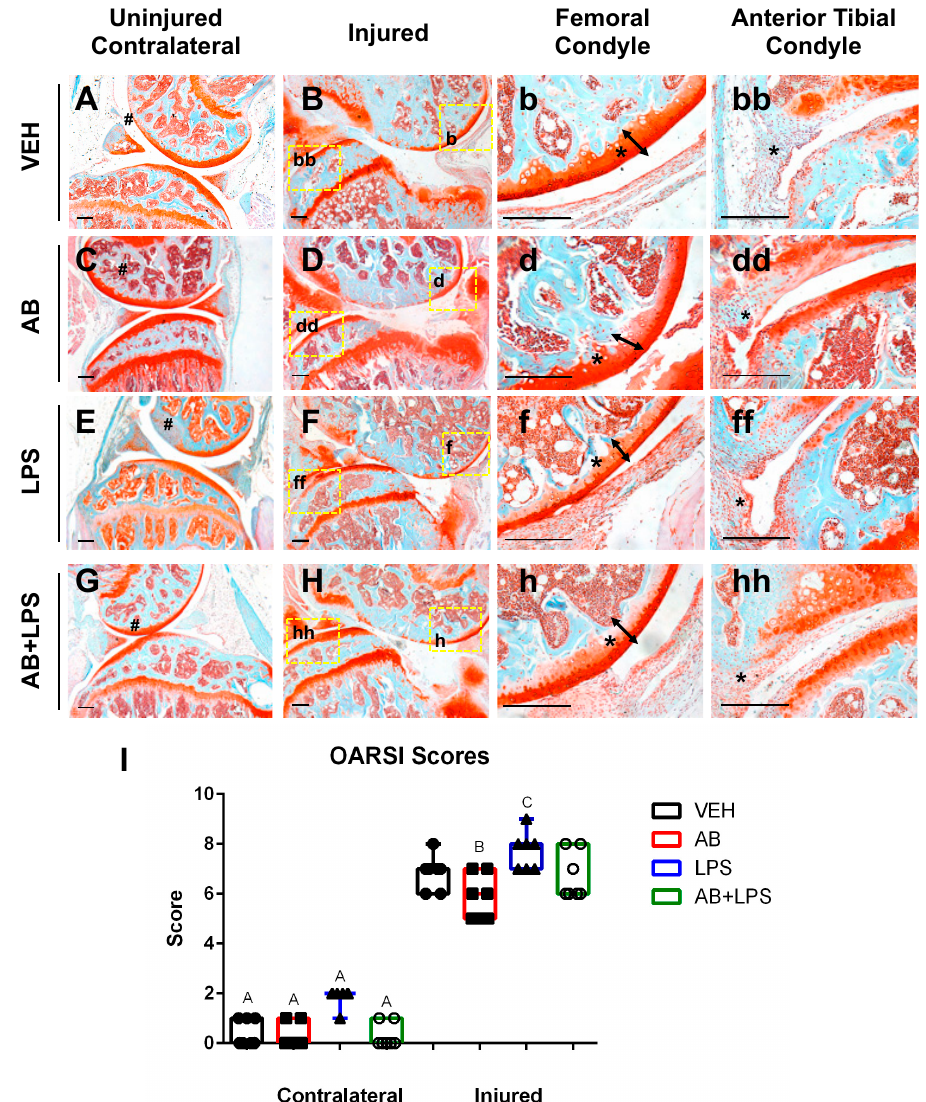
Figure 3. Characterization of PTOA-associated structural changes in the injured VEH, AB, LPS, and AB + LPS groups. ( A – hh ) Histological evaluation of uninjured and injured joints at six weeks post injury using Safranin-O and Fast Green staining. Black scale bars indicate 200 µ m. Numeral sign indicates the femoral condyle ( A , C , E , G ). High magnification images corresponding to yellow boxes ( B , D , F , H ) are provided ( b , bb , d , dd , f , ff , h , hh ). Arrows and asterisks indicate the thickness of the cartilage in the femoral condyle ( b , d , f , h ). Asterisks indicate cellularity in the synovium ( bb , dd , ff , hh ). ( I ) OARSI scores (* p -value < 0.05).